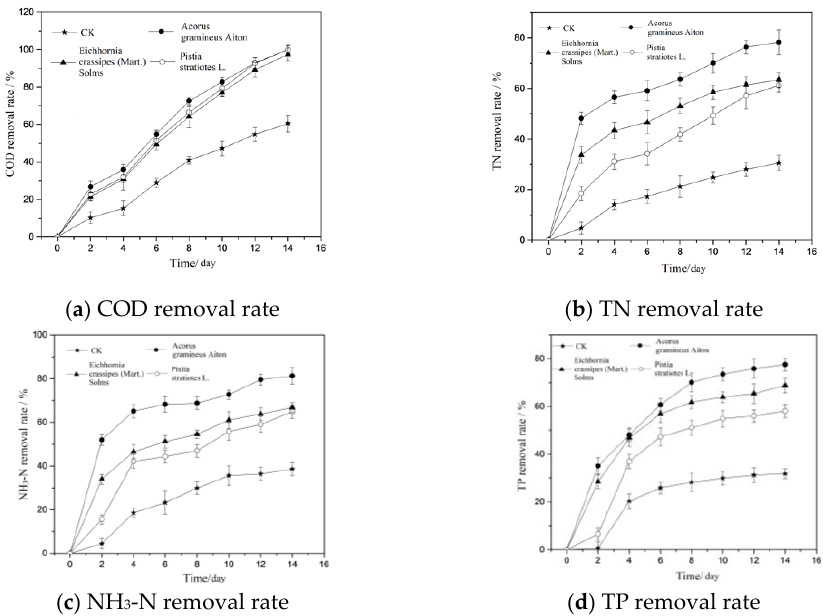
Figure 5. Removal effects of different vegetation on pollutants in water.